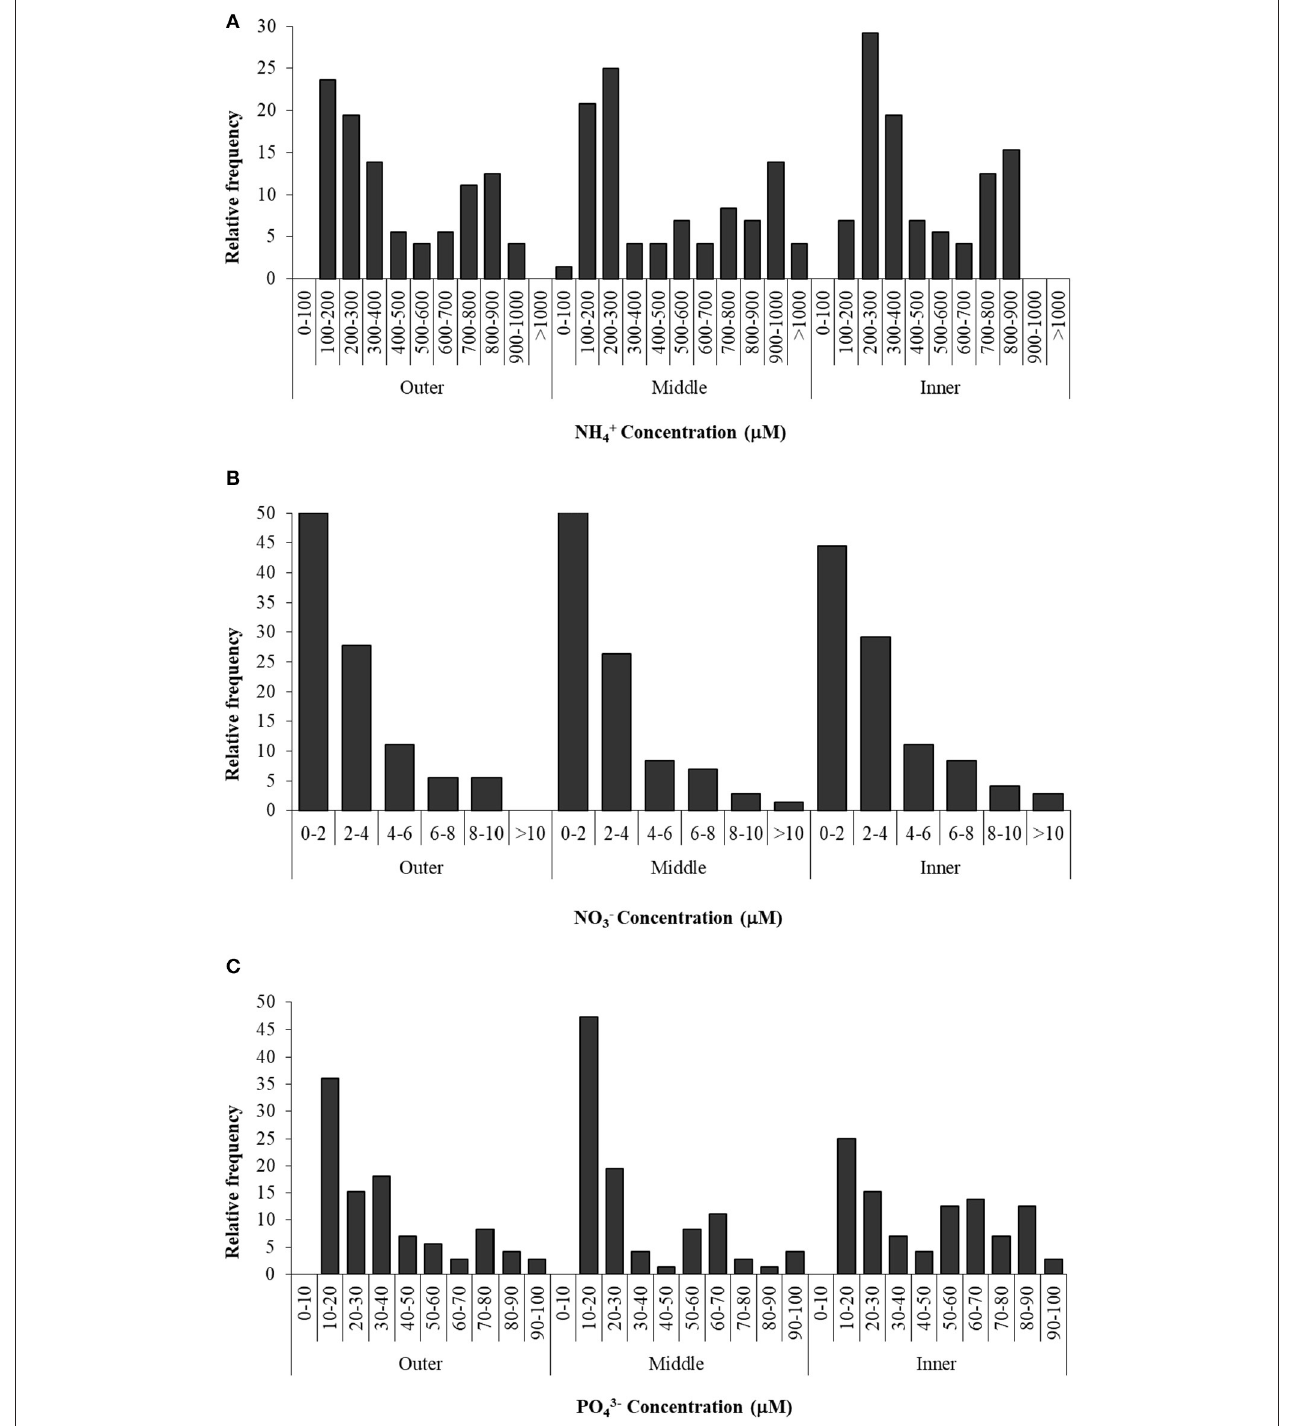
FIGURE 3 | Ammonium (A) , nitrate (B) , and phosphate (C) concentration in three zones of Palmones salt marsh soil along the seawater-land gradient (outer, middle, and inner zones), expressed as the observed frequency of each concentration range. phosphate uptake was observed in A. macrostachyum, whereas CP values much lower than in S. perennis ssp . alpini and A. portulacoides was the most efficient species, with K m and